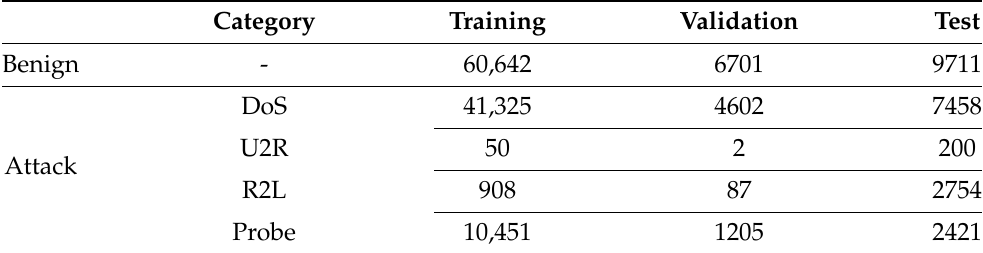
Table 1. Count Statistics of the NSL-KDD